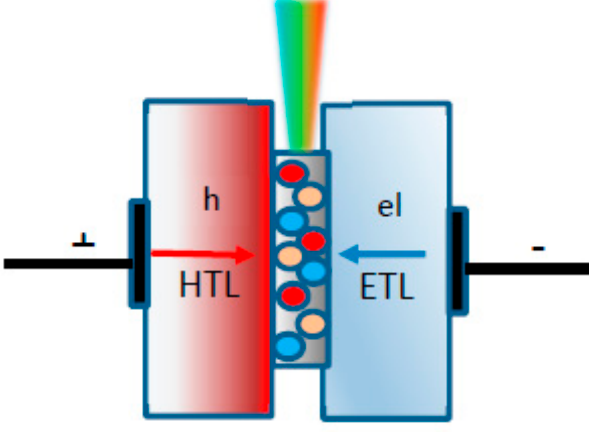
Figure 2. Schematic representation of QLED white Figure 2 . Schematic representation of QLED white emission.